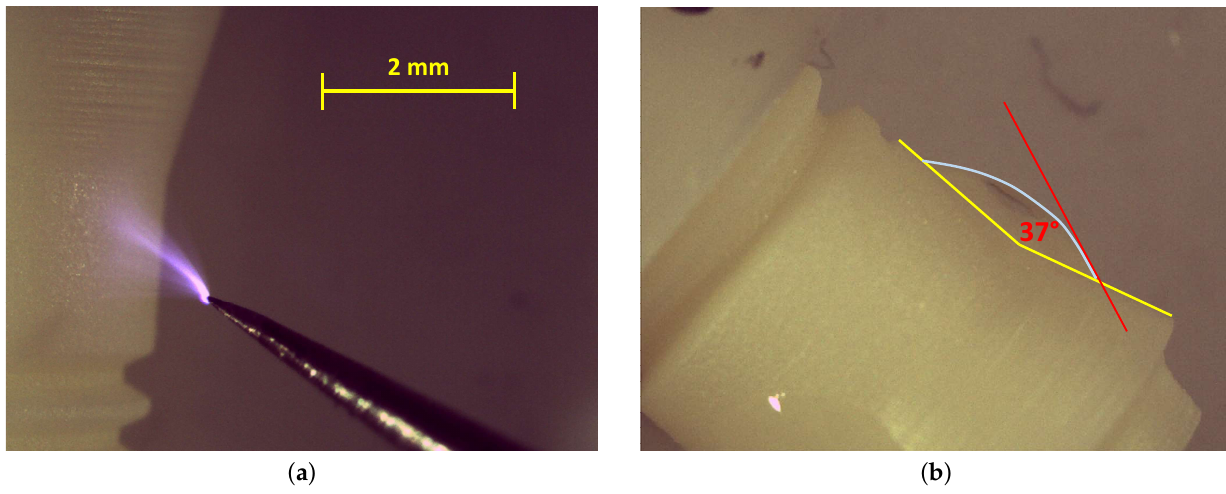
Figure 20. Y-TZP implant surface. ( a ) plasma needle treatment, and ( b ) graphical determination of the contact angle from the microscopic picture of the water droplet. The contours of the implant and of the droplet are traced for better